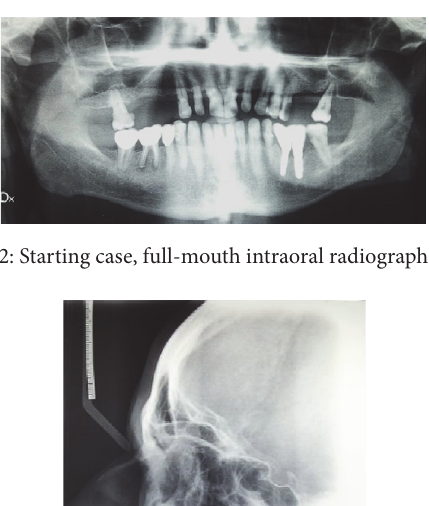
Figure 4: Initial case, TC Dentascan, axial view.